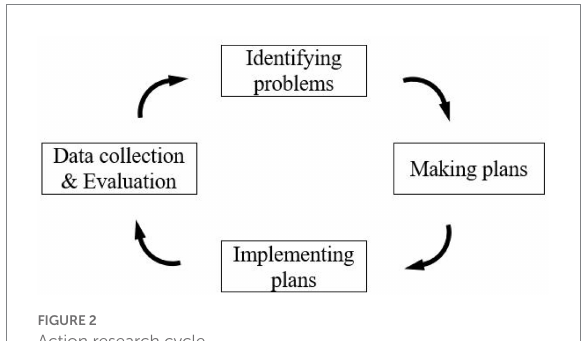
FIGURE 2 Action research